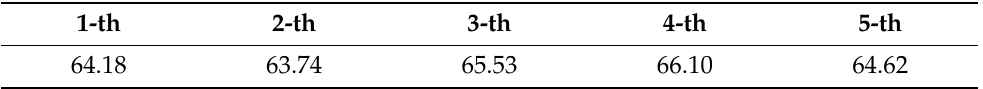
Table 10. The results of multiple experiments on the curve scene in